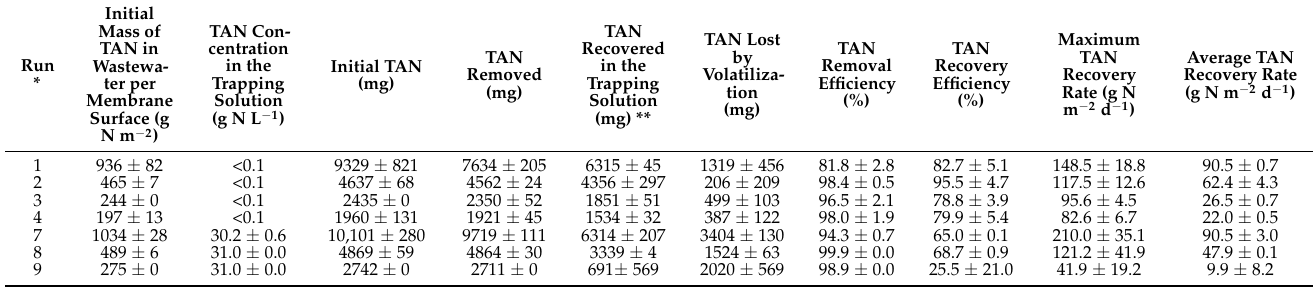
Table 2. Mass balance of the recovery of ammonia using gas-permeable membrane for Runs 1–4 (effect of initial mass of TAN in wastewater per membrane surface) and Runs 7–8 (effect of TAN concentration in the acidic trapping solution).